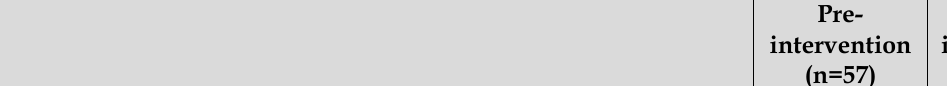
Pre- Post- intervention intervention (n=57) (n=55) NS 70%